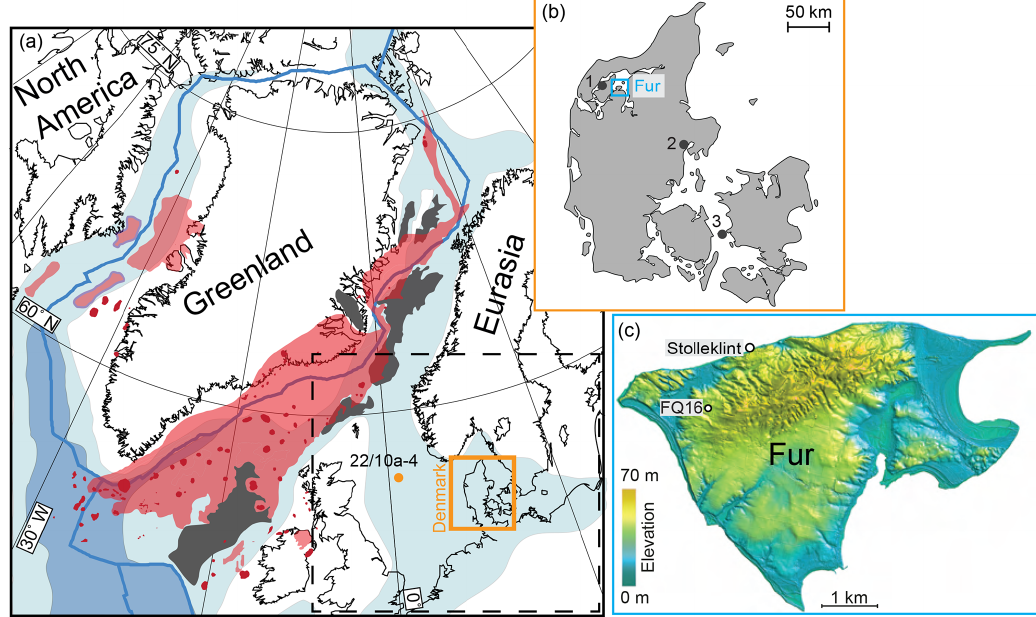
Figure 1. (a) Palaeogeographic map from 56Ma with the known NAIP extent indicated (modified from Abdelmalak et al., 2016, Horni et al., 2017, and Jones et al., 2019). The orange dot notes the position of core 22/10a-4 described by Kender et al. (2012) and Kemp et al. (2016). Blue lines: plate boundaries. Black lines: present-day coastlines. Light and dark blue areas: shelf and deep marine areas respectively. Light red areas: known extent of subaerial and submarine extrusive volcanism from the NAIP. Dark red: individual volcanic centres. Black areas: extent of known NAIP sill intrusions in sedimentary basins. The total extent of intrusions beneath the extrusive volcanism is not known. The dashed square indicates the position of Fig. 11. (b) Map of Denmark showing the location of the study area Fur. Additional locations from other relevant studies are indicated as 1 Mors, 2 Ølst, and 3 Store Bælt. (c) Topographic map of the island of Fur (22km 2 ) with the two sample sites indicated. The high topography in the north of the island is a partially overturned anticline of Fur Formation and upper Stolleklint Clay strata. Figure modified from Stokke et al.